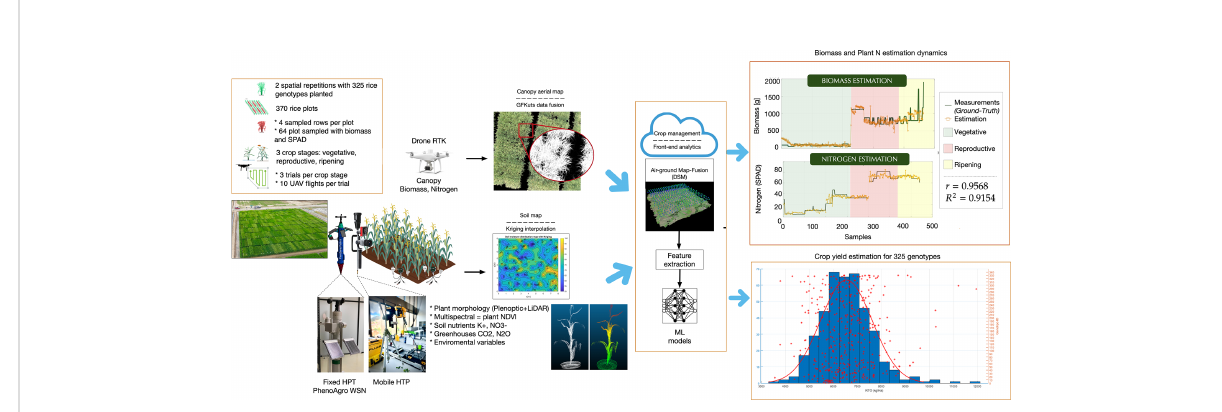
FIGURE 8 The OMICAS alliance has developed, validated and is currently deploying three High-Throughput Phenotyping (HTP) strategies and integrated platforms: aereal, terrestrial- fi xed and terrestrial-mobile. From the aereal, drone-based, multispectral imaging platform we are now able to predict leaf-N, NDVI, and other crop data; from the fi xed ground-based systems we obtain soil-based nutrients, plant indices (including metabolite pro fi les) and atmospheric state variables (including greenhouse gas footprints from crops, primarily N 2 O and CH 4